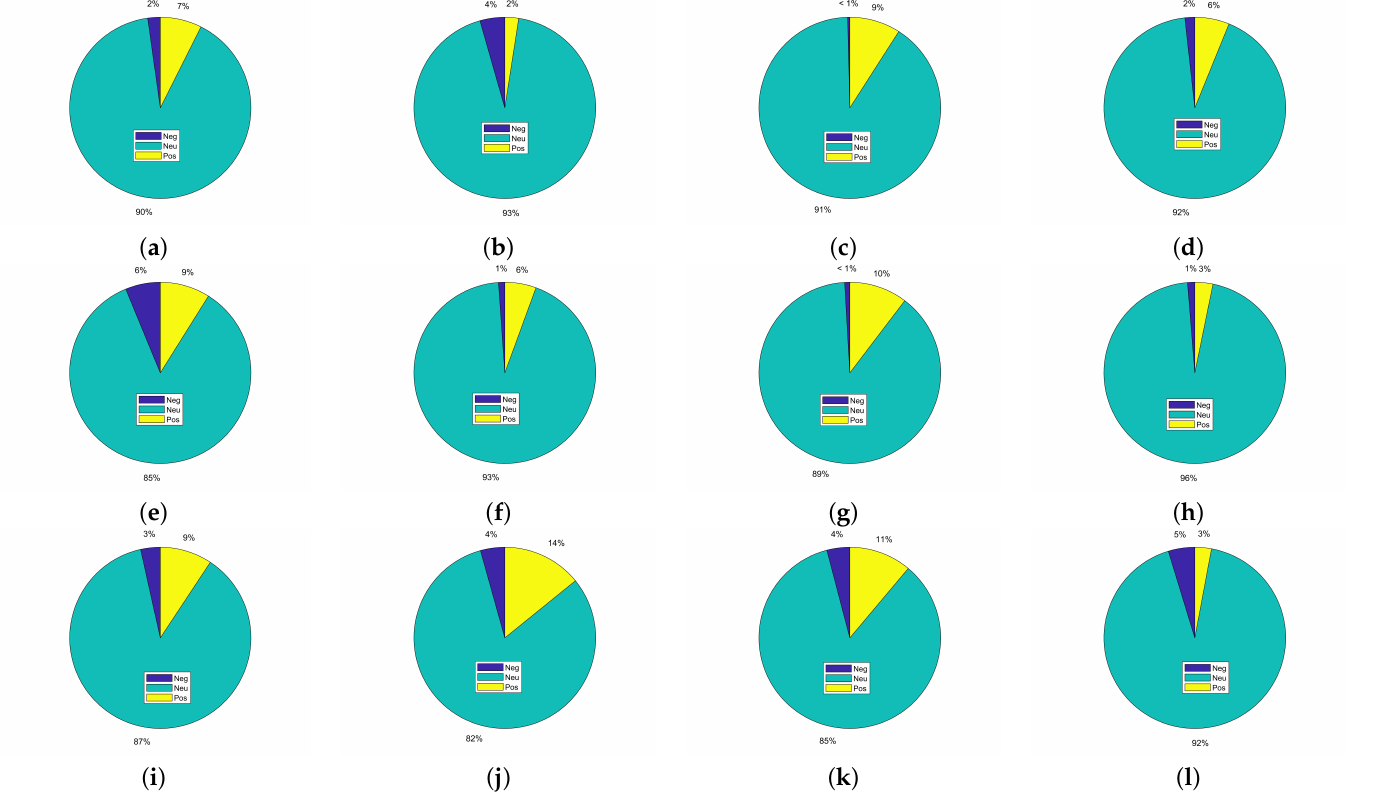
Figure 2. Distribution for negative, neutral, and positive citations from dataset-1 for articles with ≥ 100